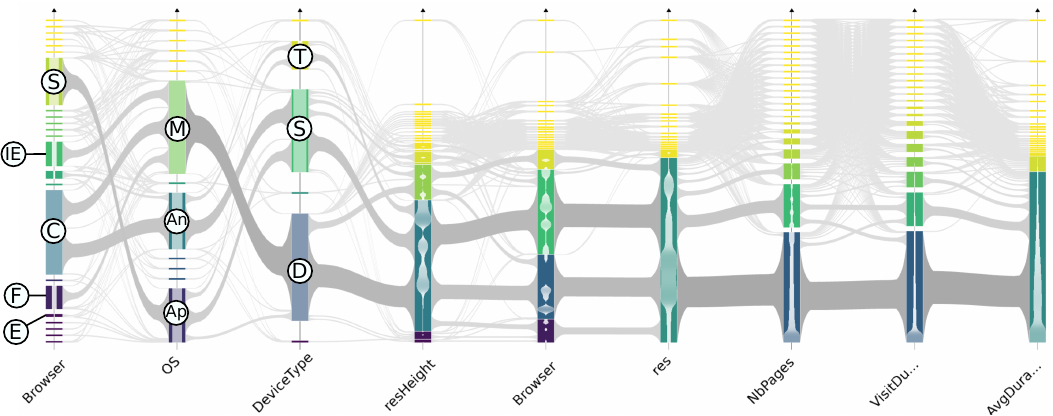
Figure 8. C2C website dataset overview with k = 30 (max. number of clusters per attributes). For this dataset, each item is a sequence of pages visited by the same user in a given time. The dataset represents various information collected during visitors navigation : system and device information (OS, browser, device, screen resolution) and navigation information (number of page visited, visit duration and average time spend per pages). The labeled clusters correspond to clusters described in the use case